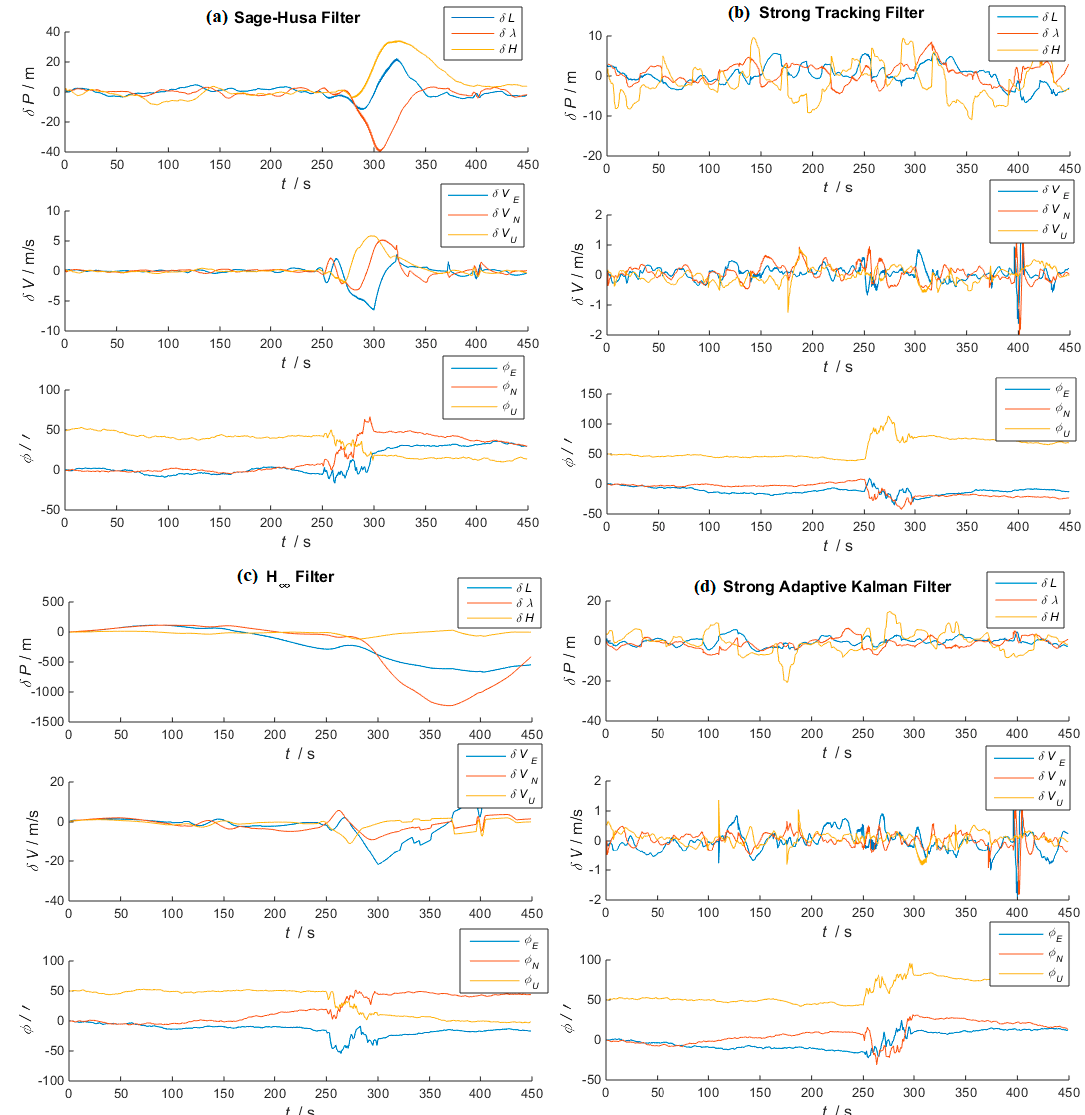
Figure 3. The diagrams of errors obtained by four types of filtering algorithms in scene 1 designed in 3.1.2. ( a ) Sage–Husa adaptive Kalman filter (SHAKF); ( b ) strong tracking filter (STF); ( c ) H ∞ filter; ( d ) strong adaptive Kalman filter (SAKF).